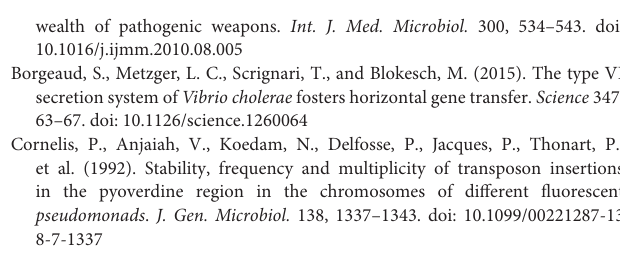
Supplementary Table 2 | Sequences of the PCR primers used in this work. Supplementary Table 3 | Original data for the E. coli killing assay. Supplementary Figure 1 | Multiple sequence alignment of the full-length IcmF protein sequences from various bacterial species. Sequences are labeled to the left by protein name and accession number, with residue numbers corresponding to the last alignable residue indicated to the right of the sequence. Red outline indicates the Walker A motif. Supplementary Figure 2 | IcmF3 is involved in siderophore production. The orange halos around the colonies were measured. (A) Relevant to Figure 5B , (B) Relevant to Figure 5C . The graph shows the mean and SD of two experiments performed in eight replicates each time. ∗ P < 0.05 ; ∗∗ P < 0.01 ; n.s.,